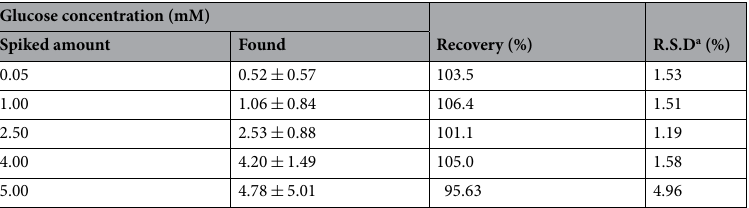
Table 2. Determination of glucose in human serum sample by our proposed Cu(II)/rGO film modified electrode. a Relative standard deviation (R.S.D.) or the coefficient of variation is used to determine if the standard deviation of data set is small or large when compared to the average. The R.S.D. of data set can be presented as either a percentage or as a number. The higher R.S.D. refers that the more spread out the results are from the mean of the data. On the other hand, a lower R.S.D. indicates that the measurement of data is more